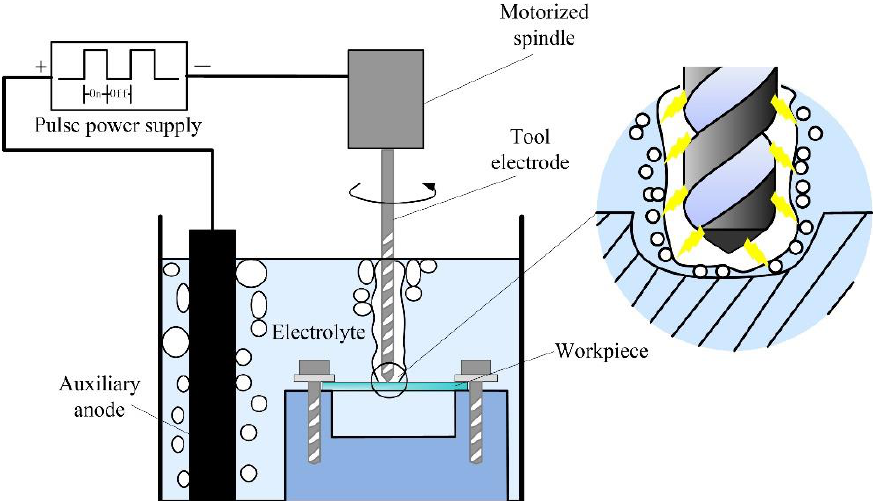
Figure 1. Schematic diagram of electrochemical discharge machining (ECDM).